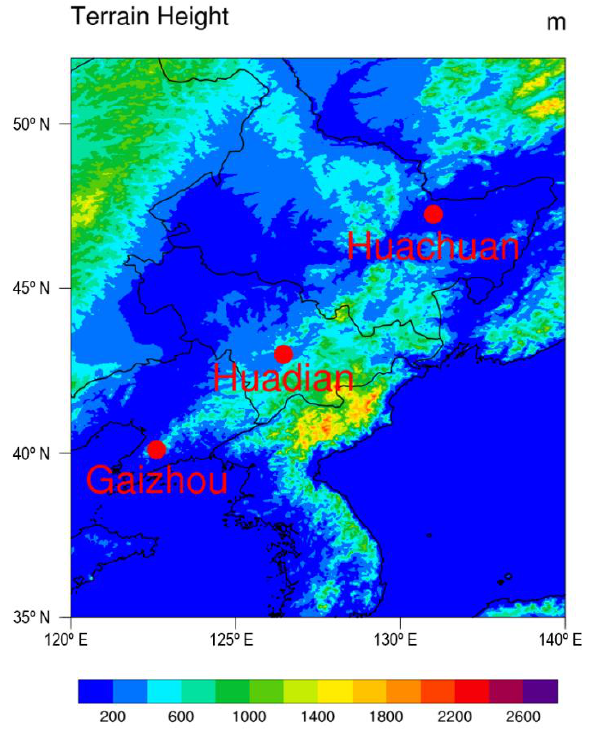
Figure 11. Topographic height map of Northeast China.